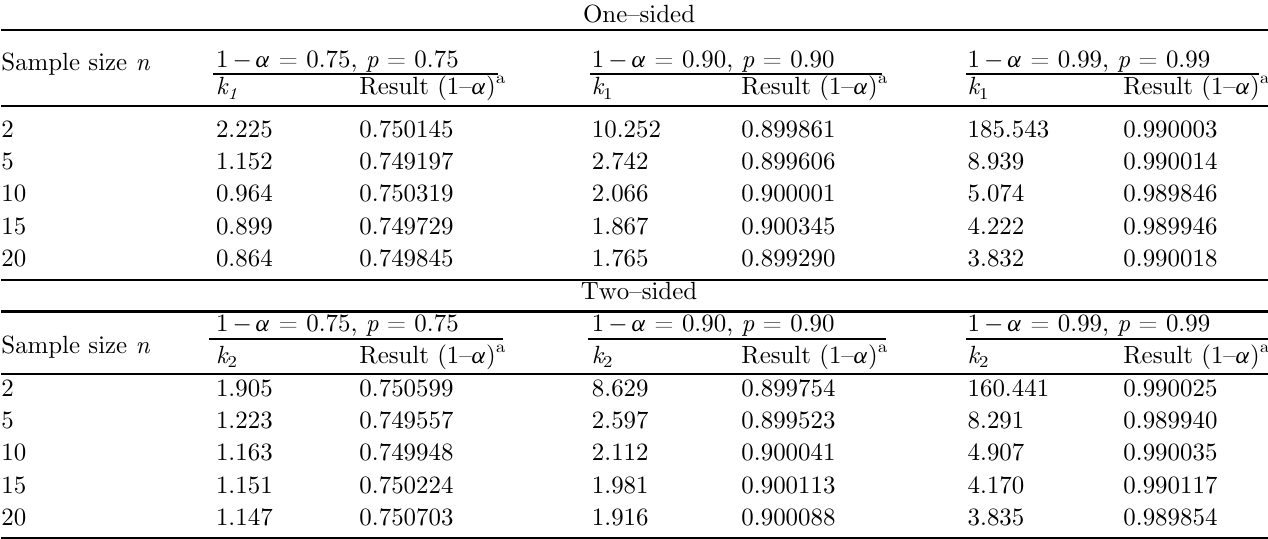
Table 4. Comparison of k k determined by new integration method and k 2